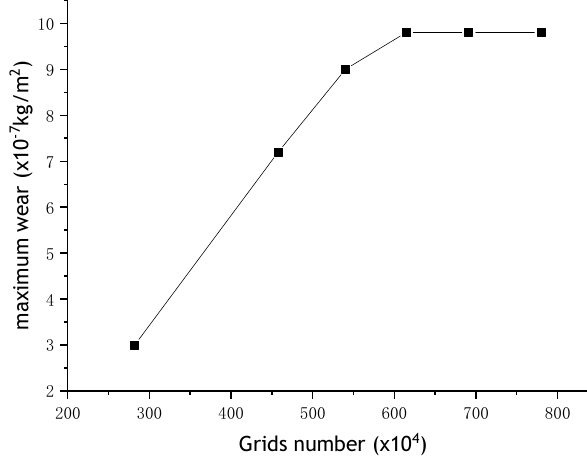
Figure 5. Grid independence verification.